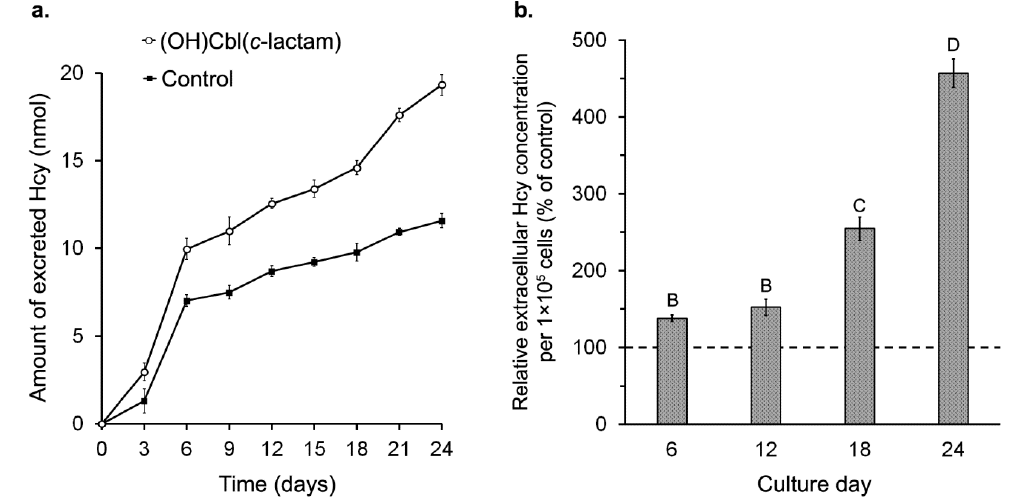
Figure 3. Homocysteine (Hcy) accumulation in culture medium during long-term incubation of melanocytes with (OH)Cbl( c -lactam). ( a ) The cumulative amount of Hcy excreted my melanocytes at the indicated time points of long-term incubation with the cobalamin antagonist; data were compared to those obtained from control cells. ( b ) The Hcy concentrations in medium collected at days 6, 12, 18, and 24; the results were normalized to 1 × 10 5 cells and expressed as a percent of the values obtained for control (control was set to 100%, indicated by dashed line). Data presented as the mean values of three independent experiments ± SD; means sharing the same letter are not significantly different at α = 0.05 (ANOVA followed by Tukey’s test, letter A for control).